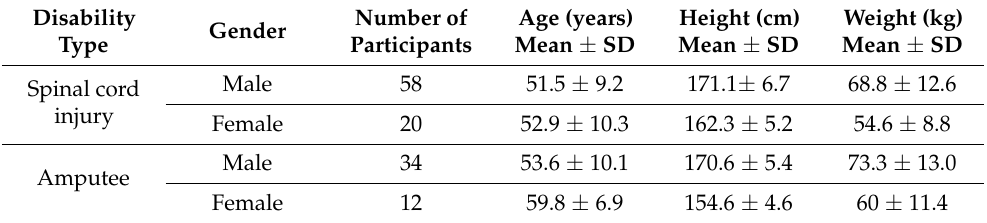
Table 3. Research participants.